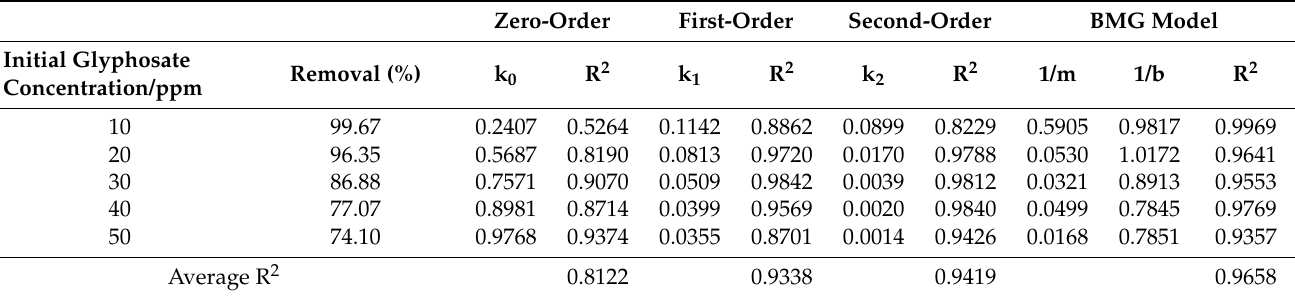
Figure 11. ( a ) Effect of the initial glyphosate concentration on glyphosate removal; ( b ) Effect of the initial glyphosate concentration on TP and COD removal (initial CaO 2 dosage = 0.5 g, the molar ratio of Ca 2+ :Fe 2+ = 6, 150 rpm, pH = 3.0, RT = 25 °C, contact time = 30 min).